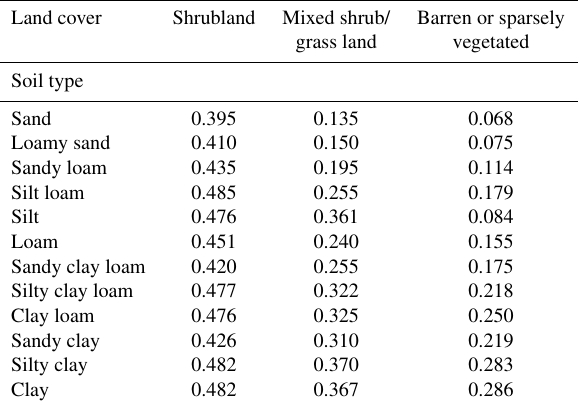
Table 1. Value of the saturation soil moisture limit ( S l )